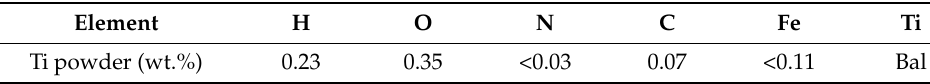
Table 1. Chemical composition of the pure titanium